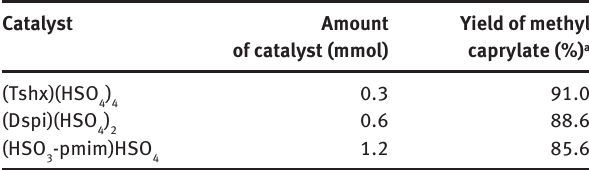
Table 2 Catalytic performances of different ionic liquids. Catalyst